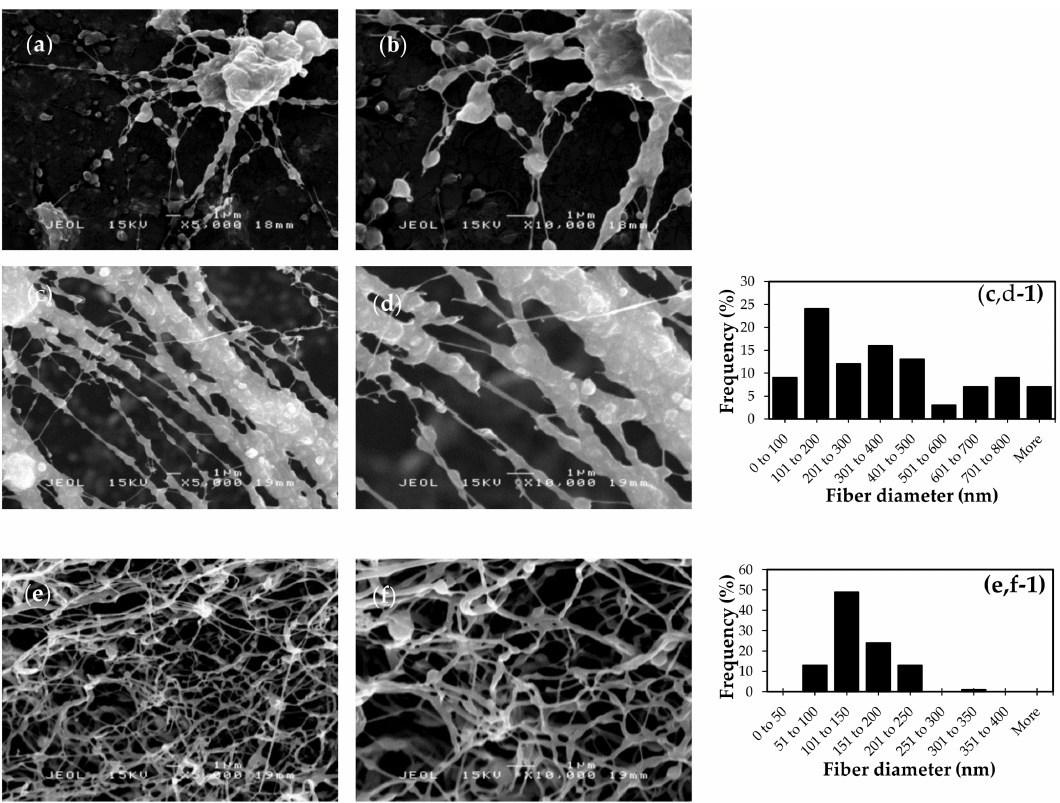
Figure 2. SEM images ( a – f ) and the corresponding fiber diameter distribution (( c,d-1 )–( e,f-1 )) of CMSP nanofibers at variation of CMSP to poly(ethylene oxide) (PEO) weight ratios ( a , b ) 3:1, ( c , d ) 1:1 and ( e , f ) 1:3 at fixed 6% solution concentration, 20 kV applied voltage, 15 cm of tip-to-collector distance and 0.8 mL / h of flow